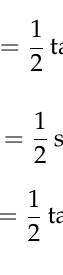
Figure 2. The spectrum of four Stokes parameters ( S 0 , S 1 , S 2 , S 3 ) and magnitude ( S = were obtained separately in k = 1 ( a ) and k = 2 states ( b ). Regarding the degree of coherence polarization ( S ), three spectrum of normalized Stokes parameters ( S (cid:48) S 0 were obtained for the k = 1 ( c ) and k = 2 states ( d ),